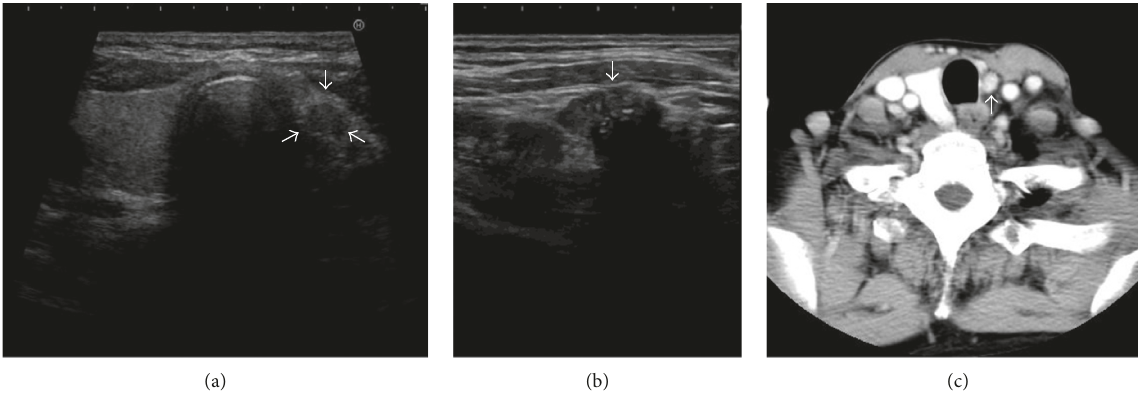
Figure 1: Findings from ultrasonography and computed tomography. The right thyroid lobe and thyroid isthmus are present, while the left lobe of the thyroid is absent. A nodule measuring 0.7 × 0.8 × 1.4cm is seen on the left side of the thyroid isthmus. On cervical ultraso- nography, the periphery of the tumor is nonuniform, small calcifications are detected in the interior, and the posterior echo is attenuated. Arrows indicate the tumor. No cervical lymph node swelling is detected.